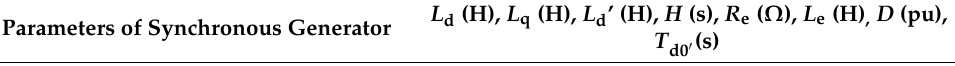
Table 1. Data of synchronous generator and network for H–P model parameters calculation. Parameters of Synchronous